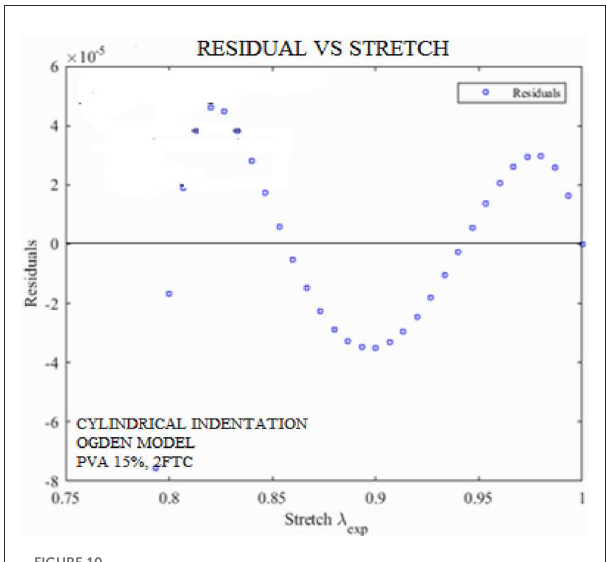
First, experimental (F–D) data are used as an input parameter for the numerical model (Abaqus). Simulated (F–D) data were then used as an input parameter for inverse analysis (MATLAB). An object junction was introduced to minimize the quadratic difference between simulated and model-predicted data. Through